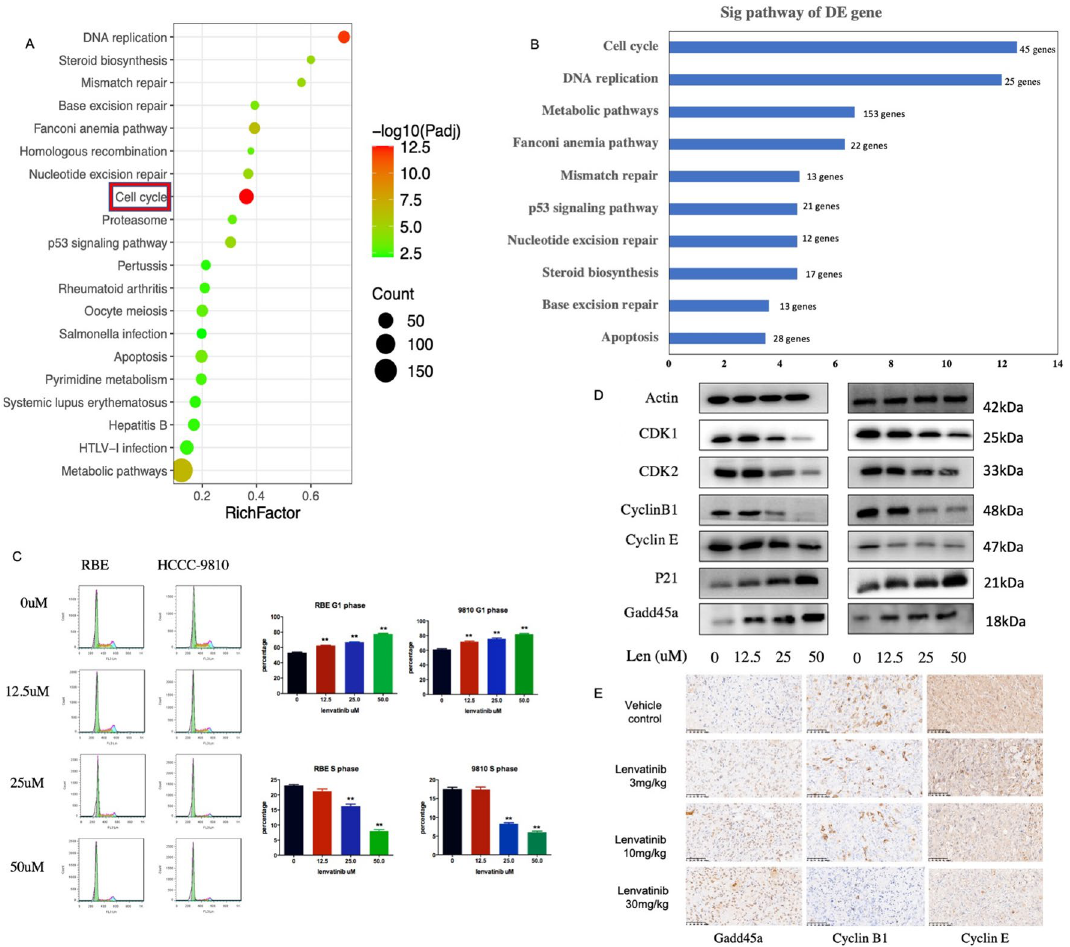
Fig. 3 Lenvatinib induces cell cycle arrest in ICC. a and b KEGG analysis of differentially expressed genes after treatment with 25 μM len- vatinib (HCCC-9810); c Cells were treated with lenvatinib at the indicated concentration for 72 h and then stained with PI for flow cytometric analysis. Each experiment was performed in triplicate. d Expression of cell cycle-related proteins in ICC cell lines after treatment with a con- centration gradient of lenvatinib for 72 h was detected using western blotting. e Cyclin B1 and Cyclin E expression were significantly down- regulated and Gadd45a expression was upregulated after lenvatinib treatment, based on immunohistochemistry (IHC) analysis (scale bar, 20 μm). * P < 0.05, ** P < 0.01, *** P < 0.001, **** P <